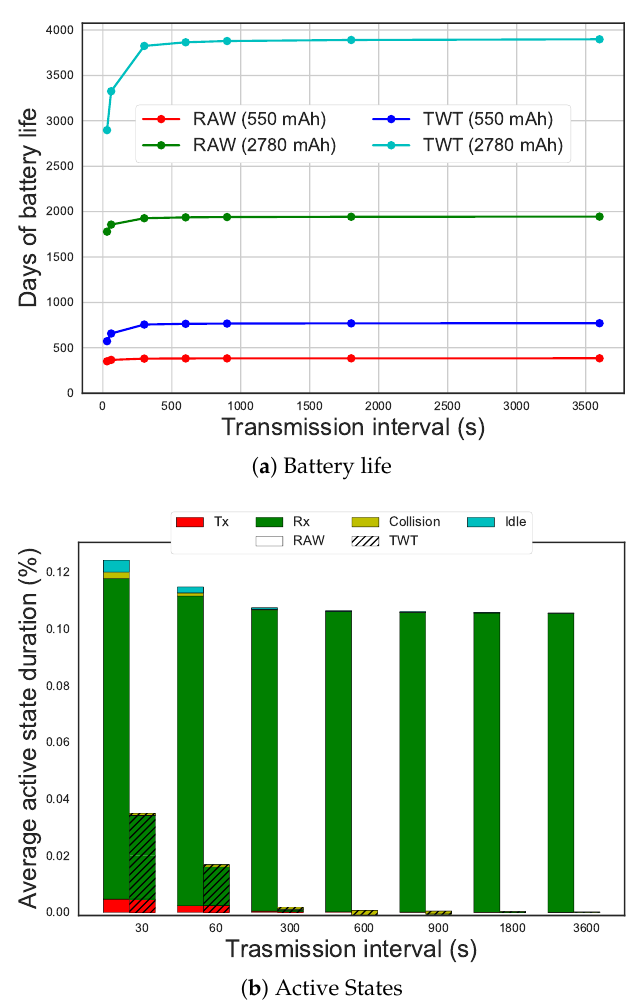
Figure 16. Battery-life using RAW and TWT with different transmission